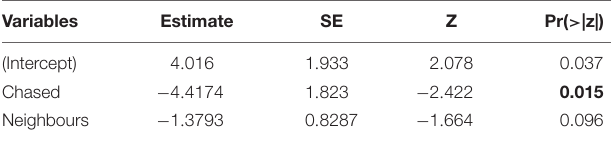
TABLE 2 | Results of the final model for the food experiments.